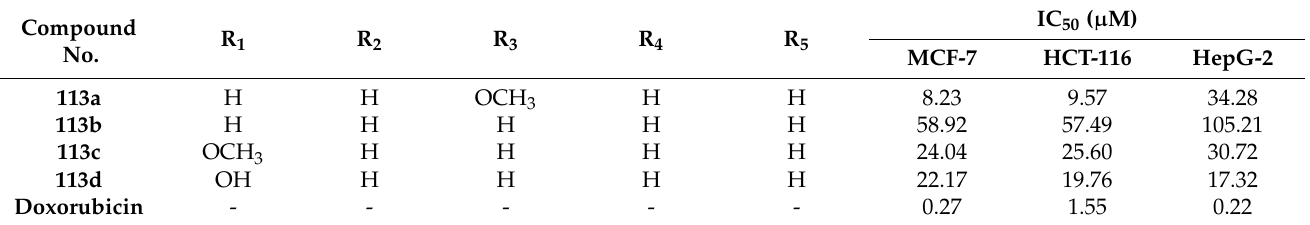
Figure 108. Structure of chalcone-based triazolo-quinoxaline hybrids and the most promising com- pound 113a. Table 95. In vitro cytotoxic activities of chalcone-based triazolo-quinoxaline hybrid compounds [ 113 ( a – d ), 113 ( a )].